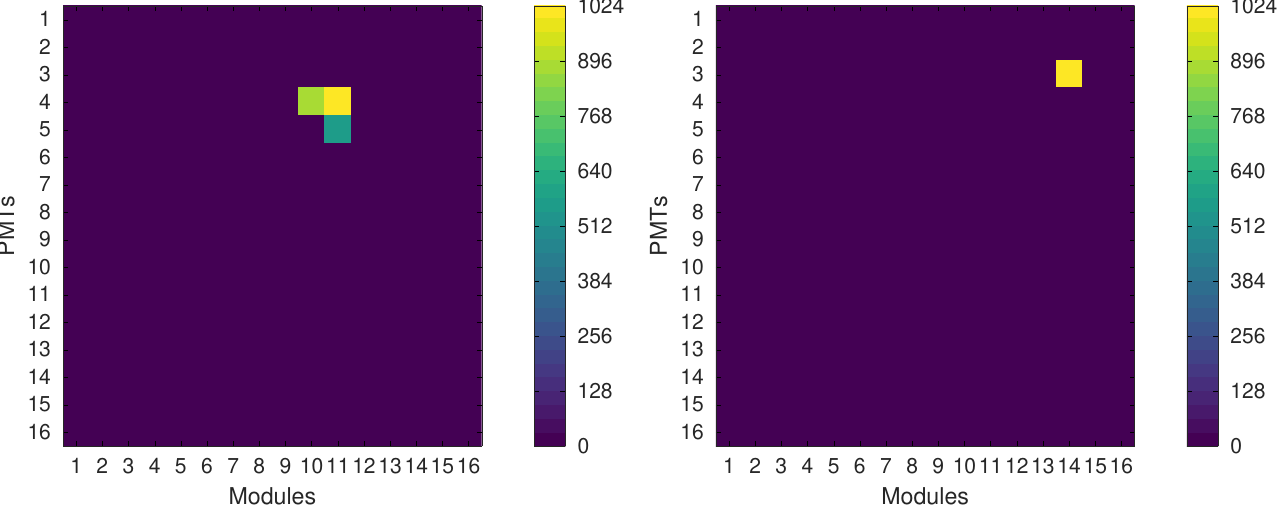
Figure 4. Examples of traces of TLFs that made active only a small group or even a single channel. Figure 5 presents two examples of linear traces broken by passing through inactive or low-sensitivity channels. In the left panel, a track spanning through seven modules is the event shown in the right panel. The track spans from PMT 1 in module 16 to PMT 16